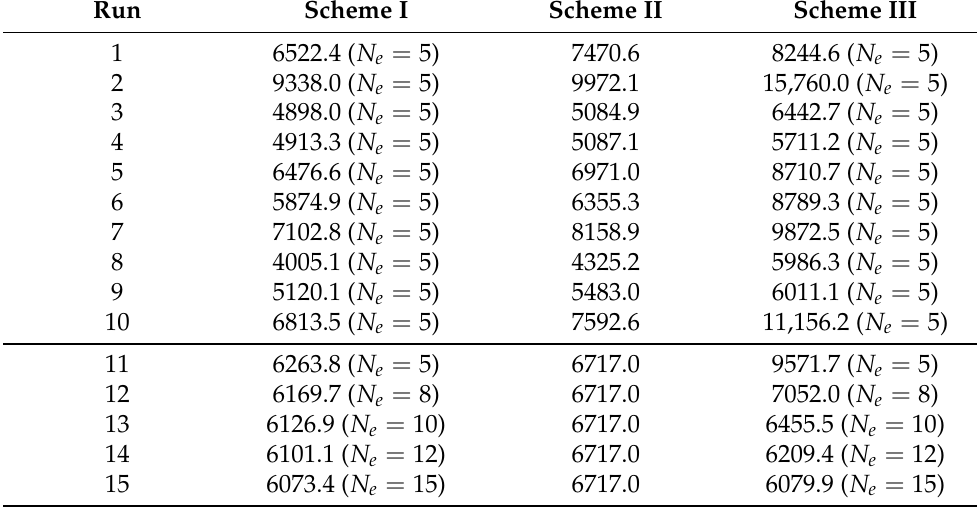
Table 2. Control performance comparison of the closed-loop process with various initial conditions, initial estimation guess, process disturbances and output measurement noise under three different schemes: (I) the proposed distributed MHE-LMPC; (II) the distributed LMPC based on the deter- ministic nonlinear observer (7); (III) a distributed MHE-LMPC scheme implemented following the proposed scheme but without constraint (9e)–(9h) in the local MHE